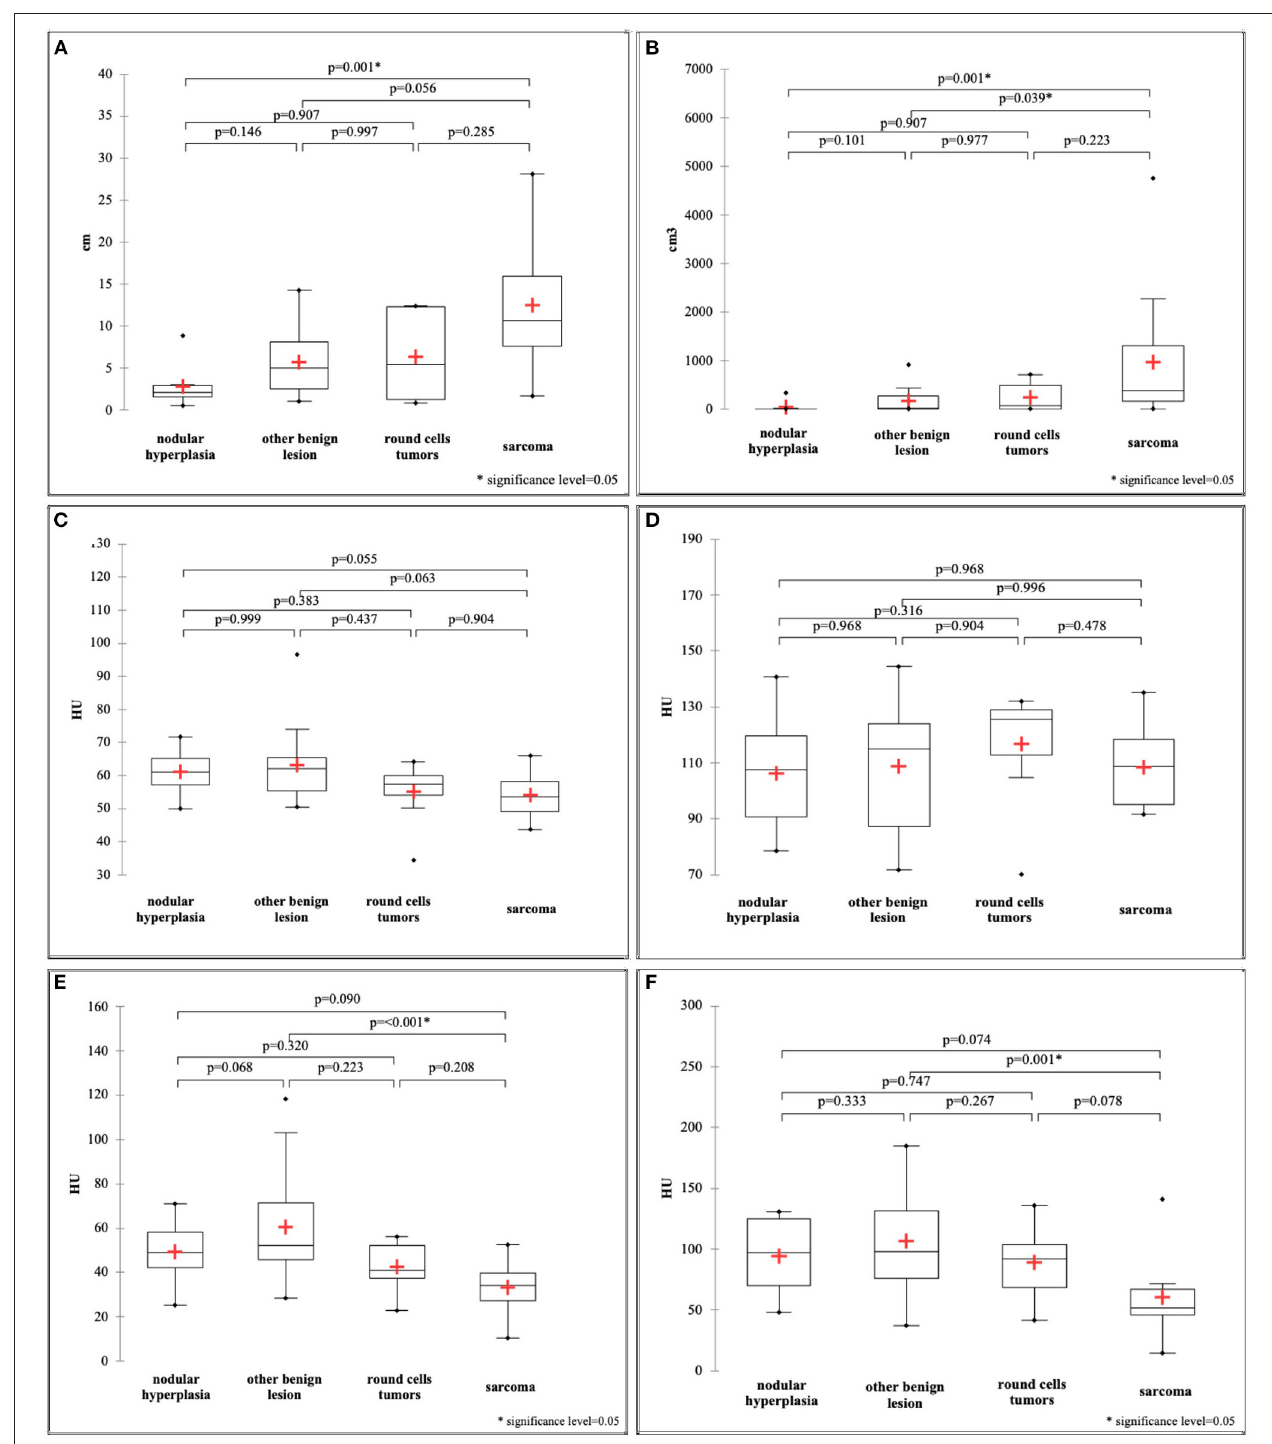
FIGURE 5 | Box and whisker plot of the maximum dimension (A) , ellipsoid volume (B) , HU value of the pre-contrast normal spleen (C) , HU value of the post-contrast normal spleen (D) , HU value of the pre-contrast lesion (E) , HU value of the post-contrast lesion (F) . NH nodules are reported as having a variable appearance results of both the discriminant analysis and the decision tree confirm such findings and, in fact, NHs were characterised (both homogeneous and heterogeneous) and as being markedly hyperenhancing on post-contrast CT images (2, 6, 7). The by higher pre- and post-contrast HU values and a